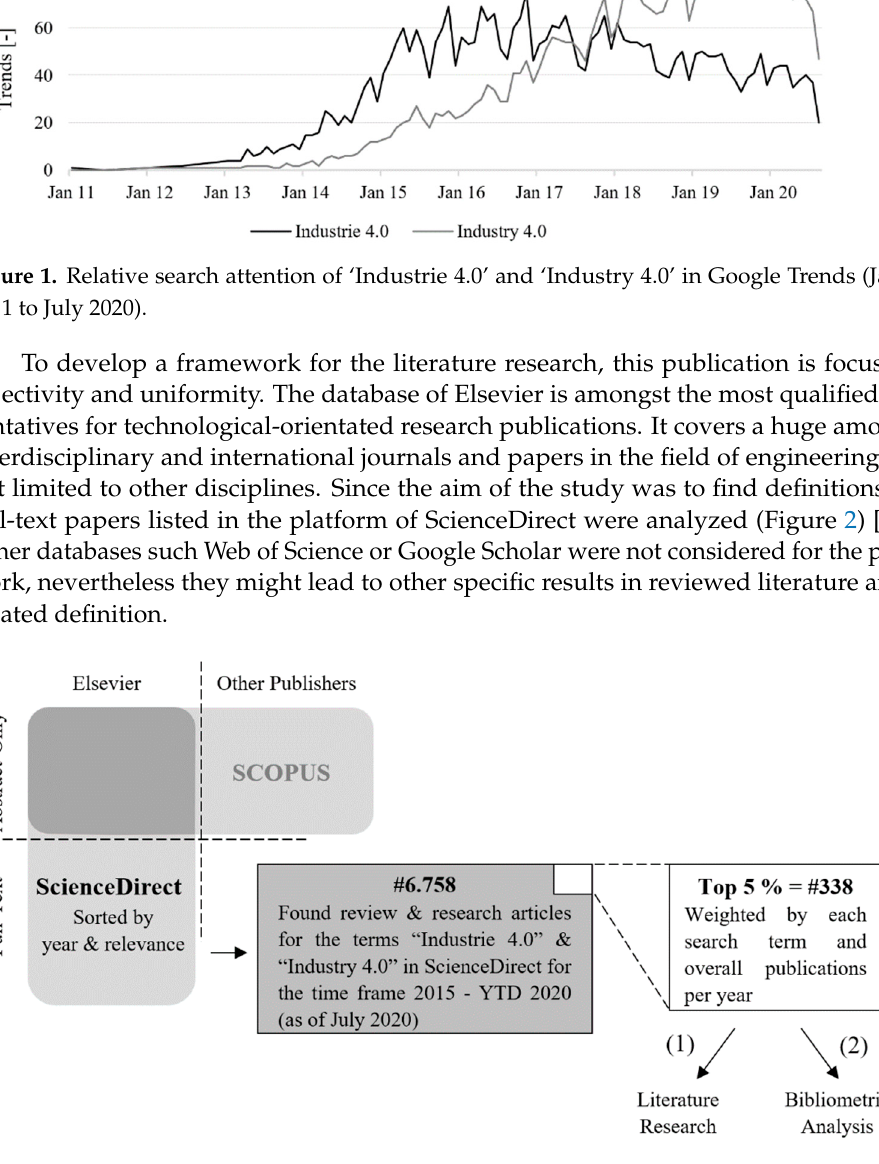
Figure 2. Developed methodology and workflow for literature research.